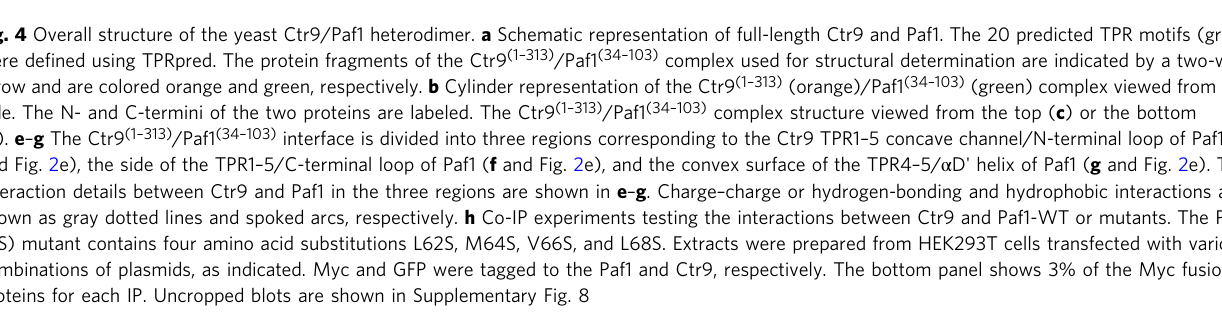
Fig. 4 Overall structure of the yeast Ctr9/Paf1 heterodimer. a Schematic representation of full-length Ctr9 and Paf1. The 20 predicted TPR motifs (gray) were de fi ned using TPRpred. The protein fragments of the Ctr9 (1 – 313) /Paf1 (34 – 103) complex used for structural determination are indicated by a two-way arrow and are colored orange and green, respectively. b Cylinder representation of the Ctr9 (1 – 313) (orange)/Paf1 (34 – 103) (green) complex viewed from the side. The N- and C-termini of the two proteins are labeled. The Ctr9 (1 – 313) /Paf1 (34 – 103) complex structure viewed from the top ( c ) or the bottom ( d ). e – g The Ctr9 (1 – 313) /Paf1 (34 – 103) interface is divided into three regions corresponding to the Ctr9 TPR1 – 5 concave channel/N-terminal loop of Paf1 ( e and Fig. 2e), the side of the TPR1 – 5/C-terminal loop of Paf1 ( f and Fig. 2e), and the convex surface of the TPR4 – 5/ α D' helix of Paf1 ( g and Fig. 2e). The interaction details between Ctr9 and Paf1 in the three regions are shown in e – g . Charge – charge or hydrogen-bonding and hydrophobic interactions are shown as gray dotted lines and spoked arcs, respectively. h Co-IP experiments testing the interactions between Ctr9 and Paf1-WT or mutants. The Paf1 (4S) mutant contains four amino acid substitutions L62S, M64S, V66S, and L68S. Extracts were prepared from HEK293T cells transfected with various combinations of plasmids, as indicated. Myc and GFP were tagged to the Paf1 and Ctr9, respectively. The bottom panel shows 3% of the Myc fusion proteins for each IP. Uncropped blots are shown in Supplementary